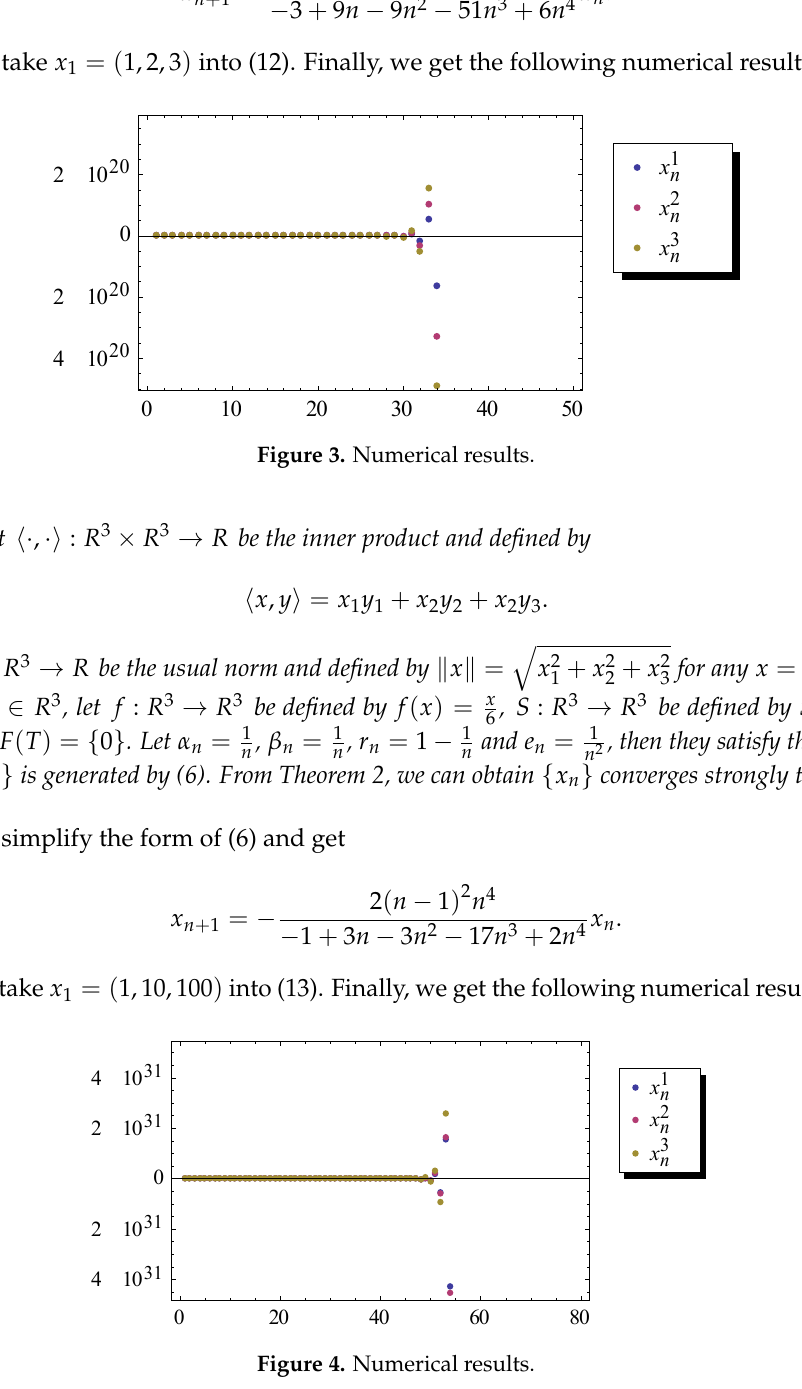
Figure 4. Numerical results.